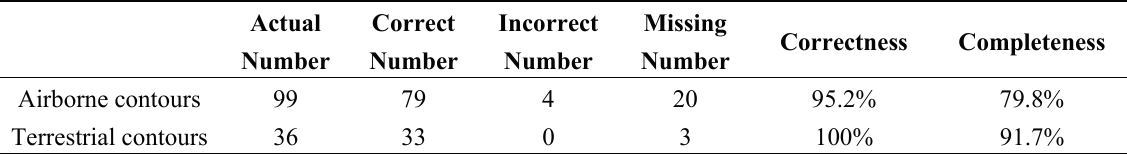
Table 1. Evaluation of the correctness and completeness of building contours. Actual Correct Airborne